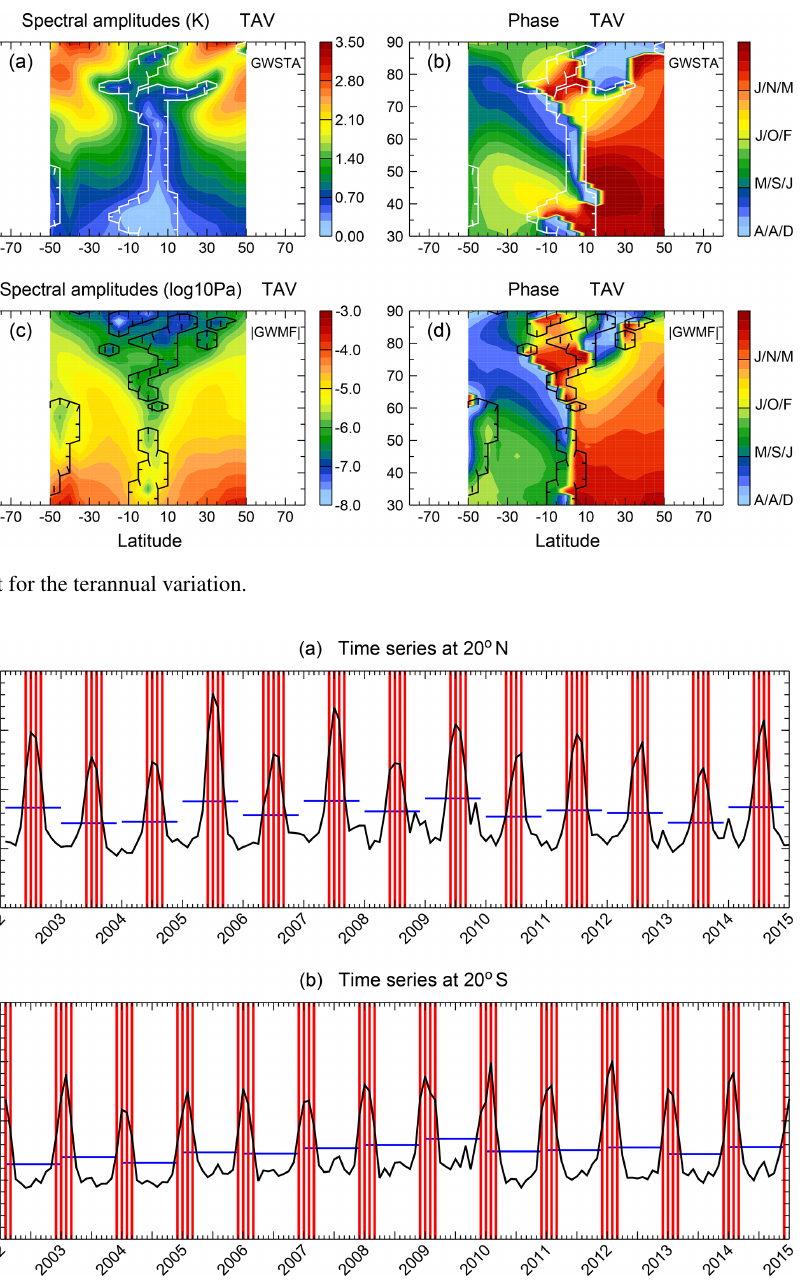
Figure 6. Time series of SABER absolute GWMF at 30km for the latitudes 20 ◦ N (a) and 20 ◦ S (b) . Blue horizontal lines represent the average values of each year. Red lines mark values that exceed the annual average